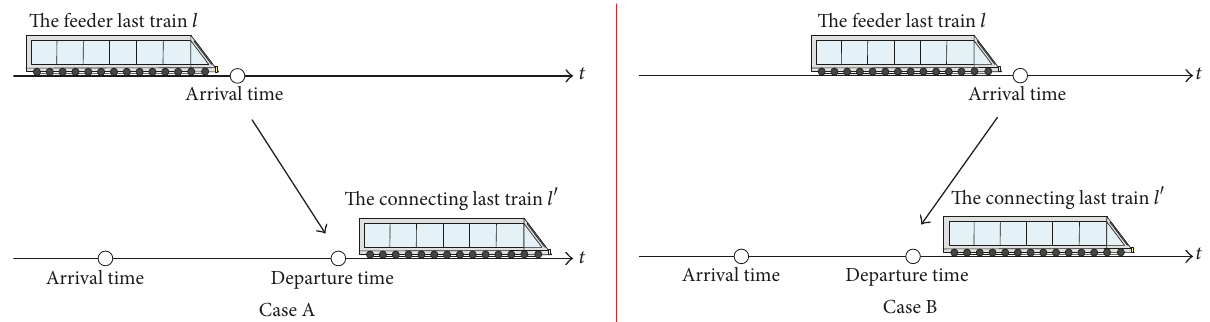
Figure 1: Transfer situations based on the arrival and departure times of last